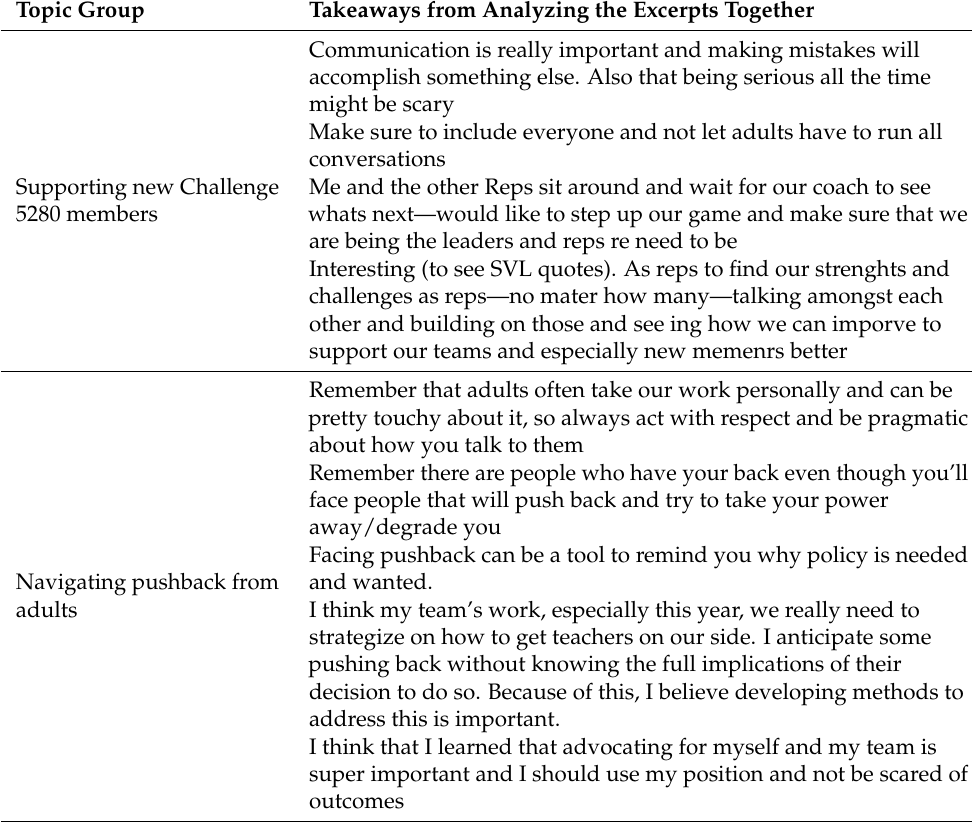
Table 5. Examples of “takeaways” on post-its written by students. Topic Group Takeaways from Analyzing the Excerpts